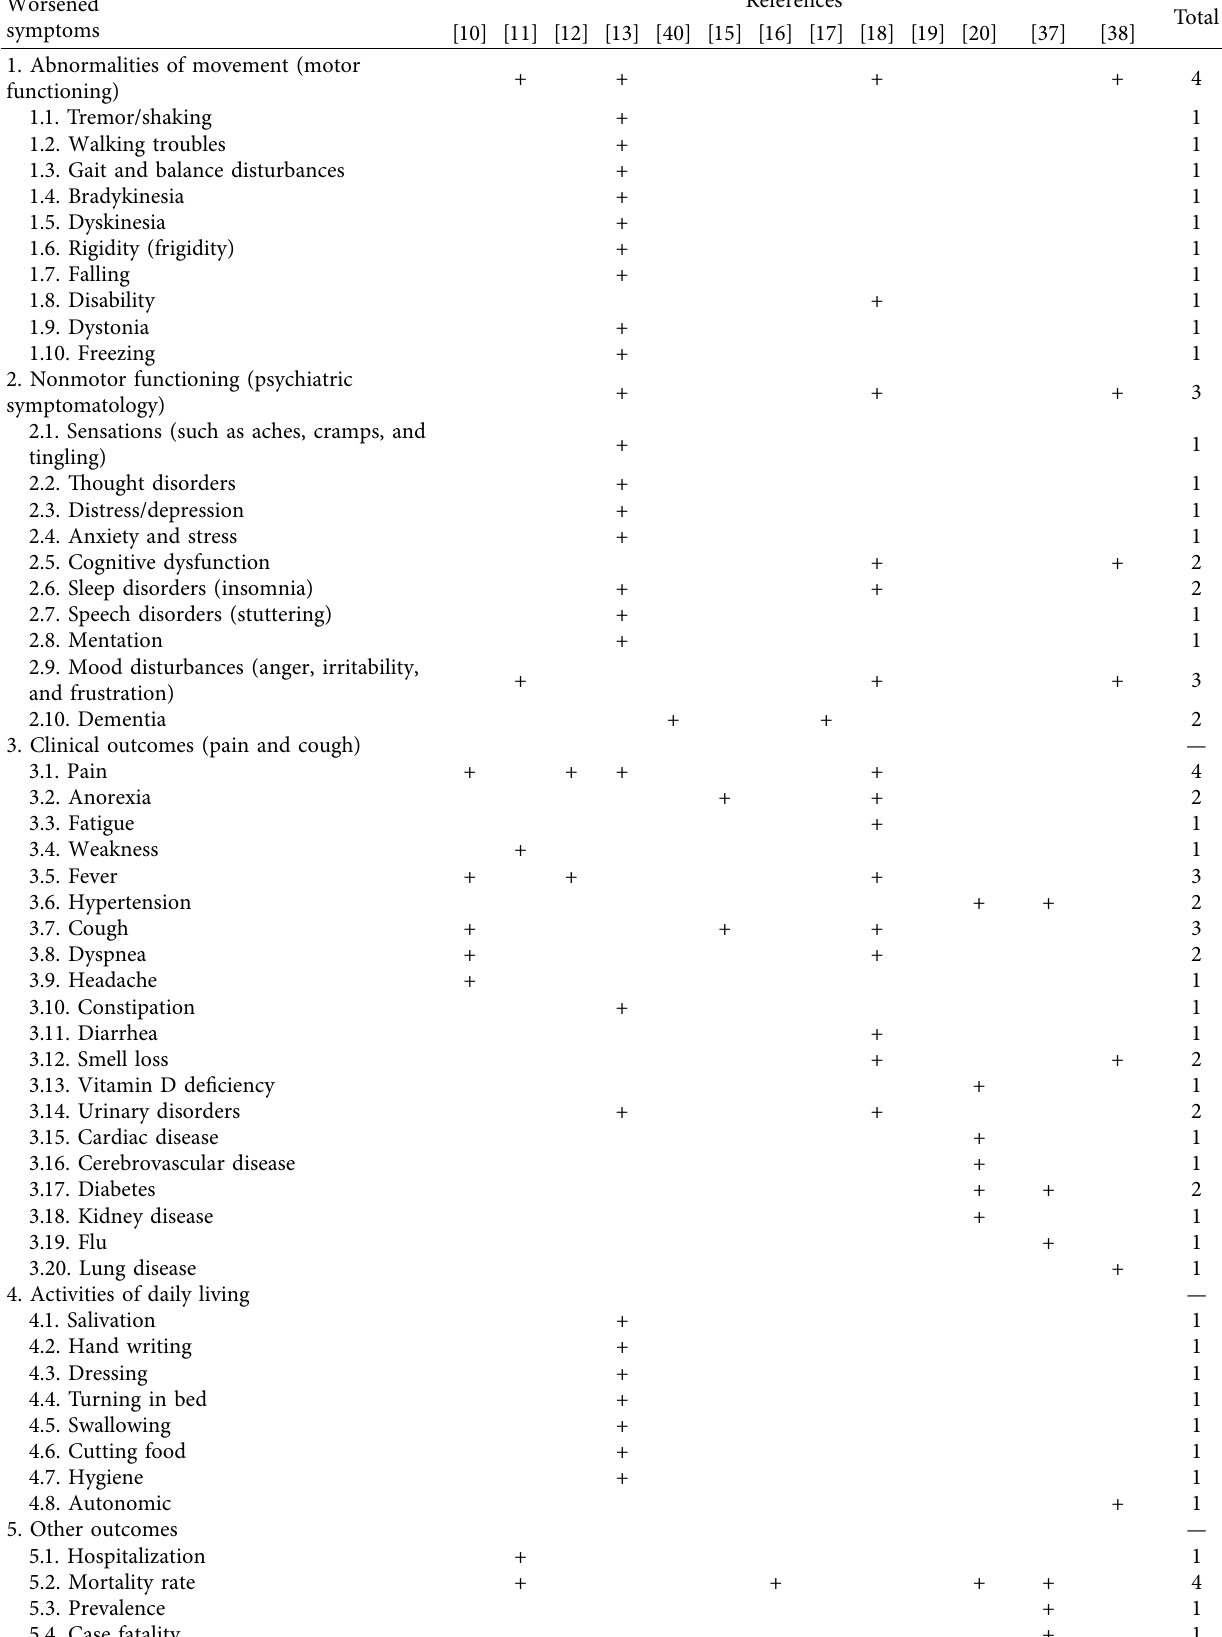
Table 7: Symptoms and consequences of Parkinson’s patients with